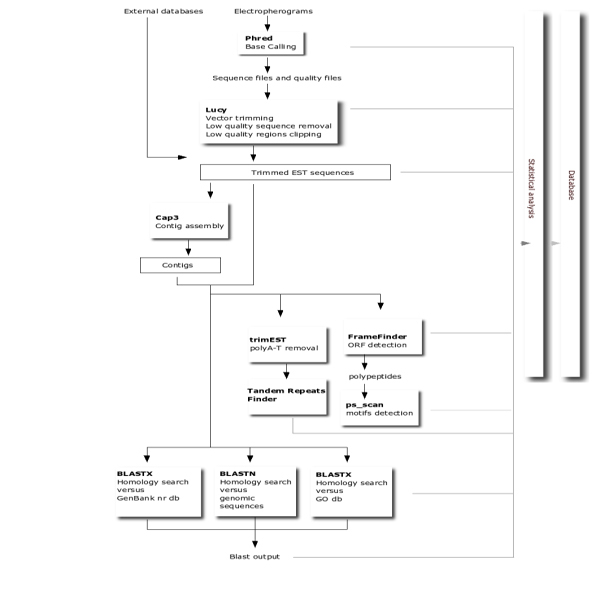
The ESTuber db pipeline. Data flow among the main programs included in the ESTuber db pipeline. Accessory programs were excluded from the chart.